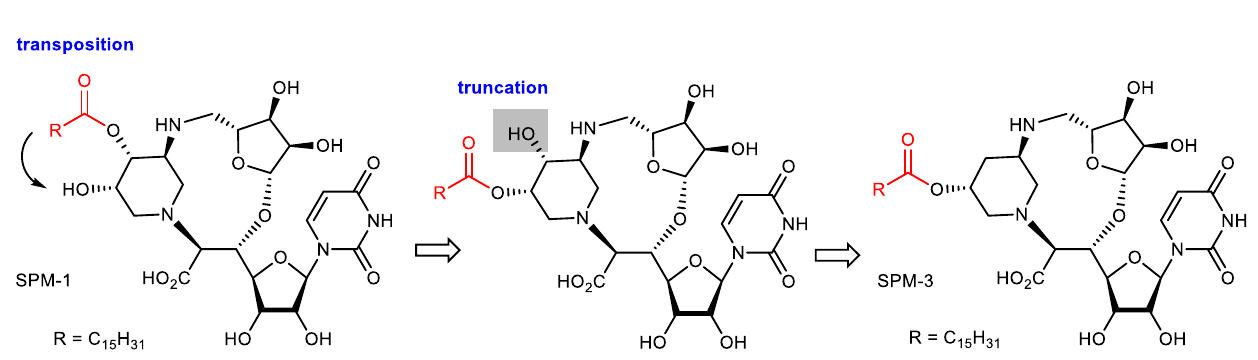
Fig. 8 | Structure-based design of SPM-3. The palmitoyl group of SPM-1 is moved to the adjacent 5 ′′′ -hydroxyl group. The resulting 4 ′′′ -hydroxy group is truncated to reduce the polarity of the